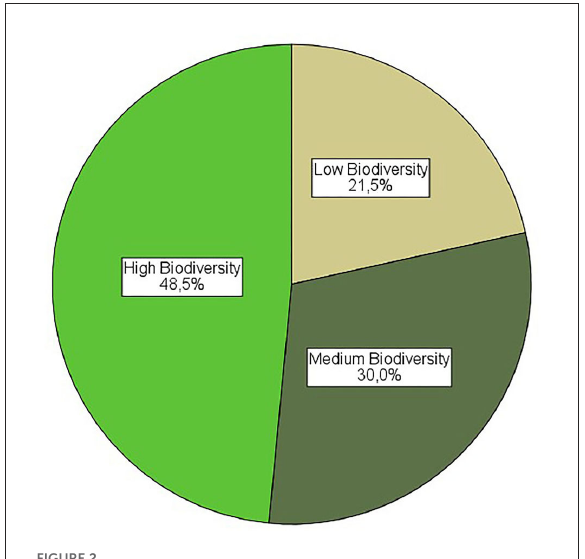
FIGURE2 Percentages in preferences for high, medium, and low